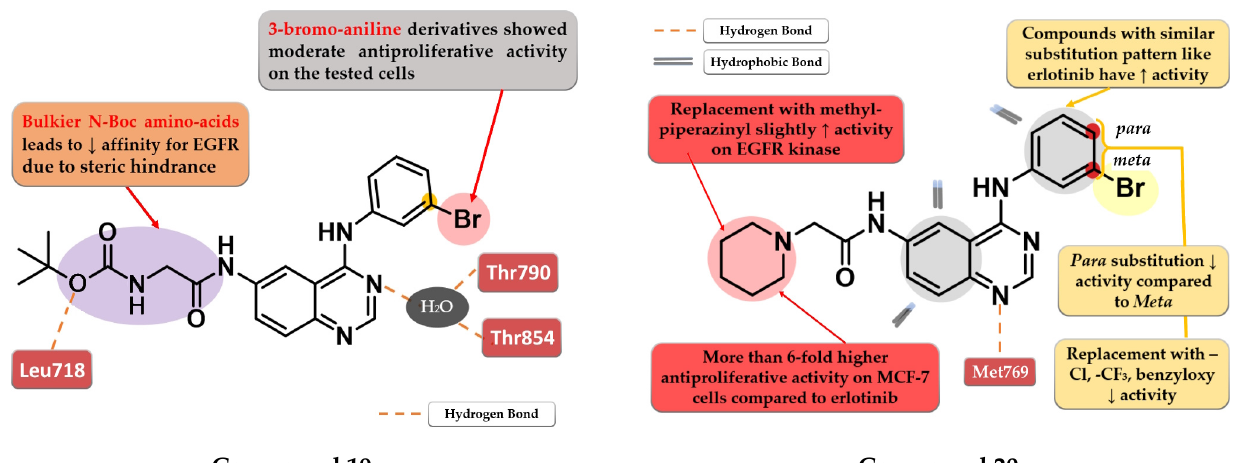
Figure 12. Structure–activity relationship and molecular docking of compound 19 in the human EGFR kinase domain (PDB ID 2ITY) [51], as reported by Zheng et al. [125]; structure–activity relationship and molecular docking of compound 20 in the human EGFR kinase domain (PDB ID 1XKK) [101], as reported by Ismail et al. [126].